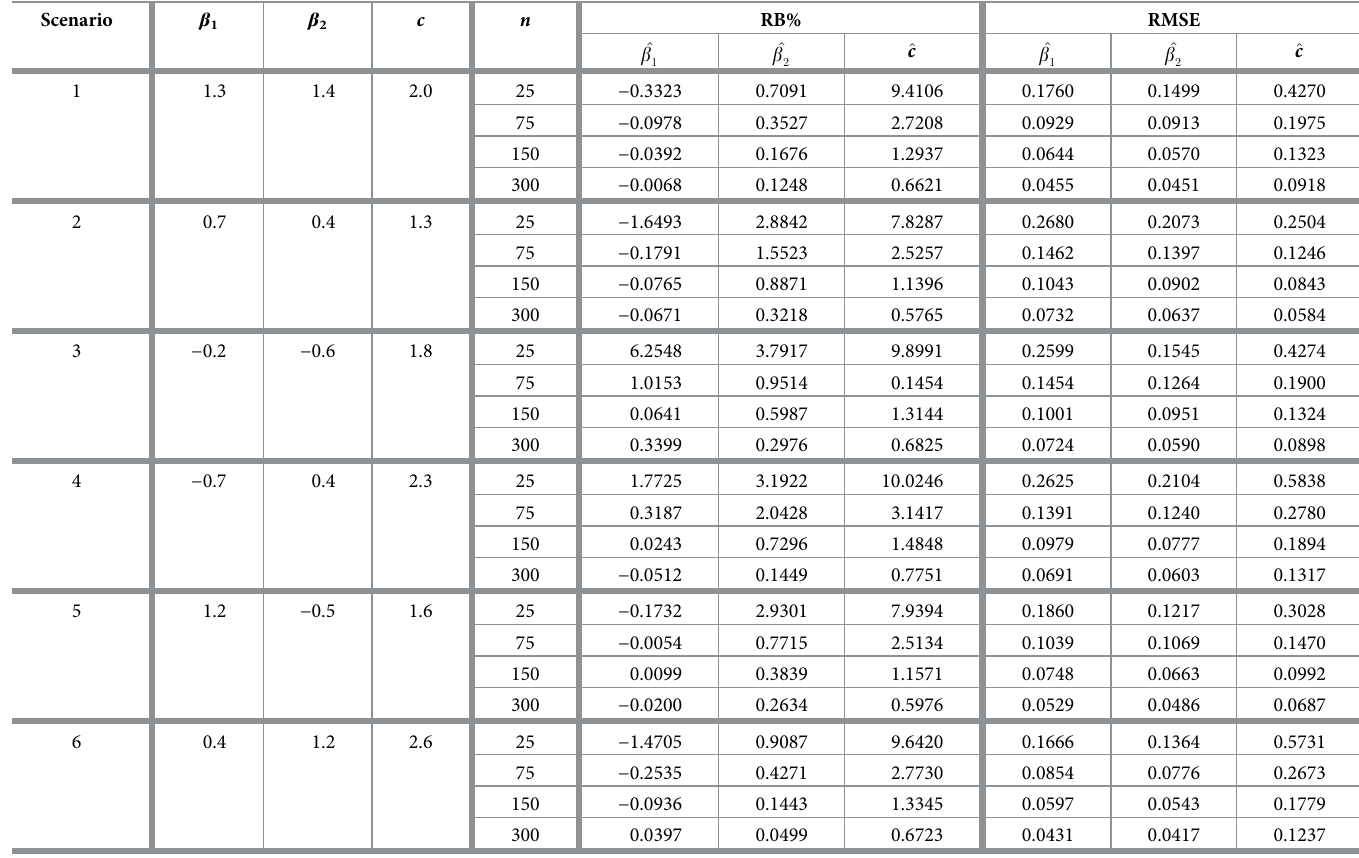
Table 2. RB%s and RMSEs for the UBXII